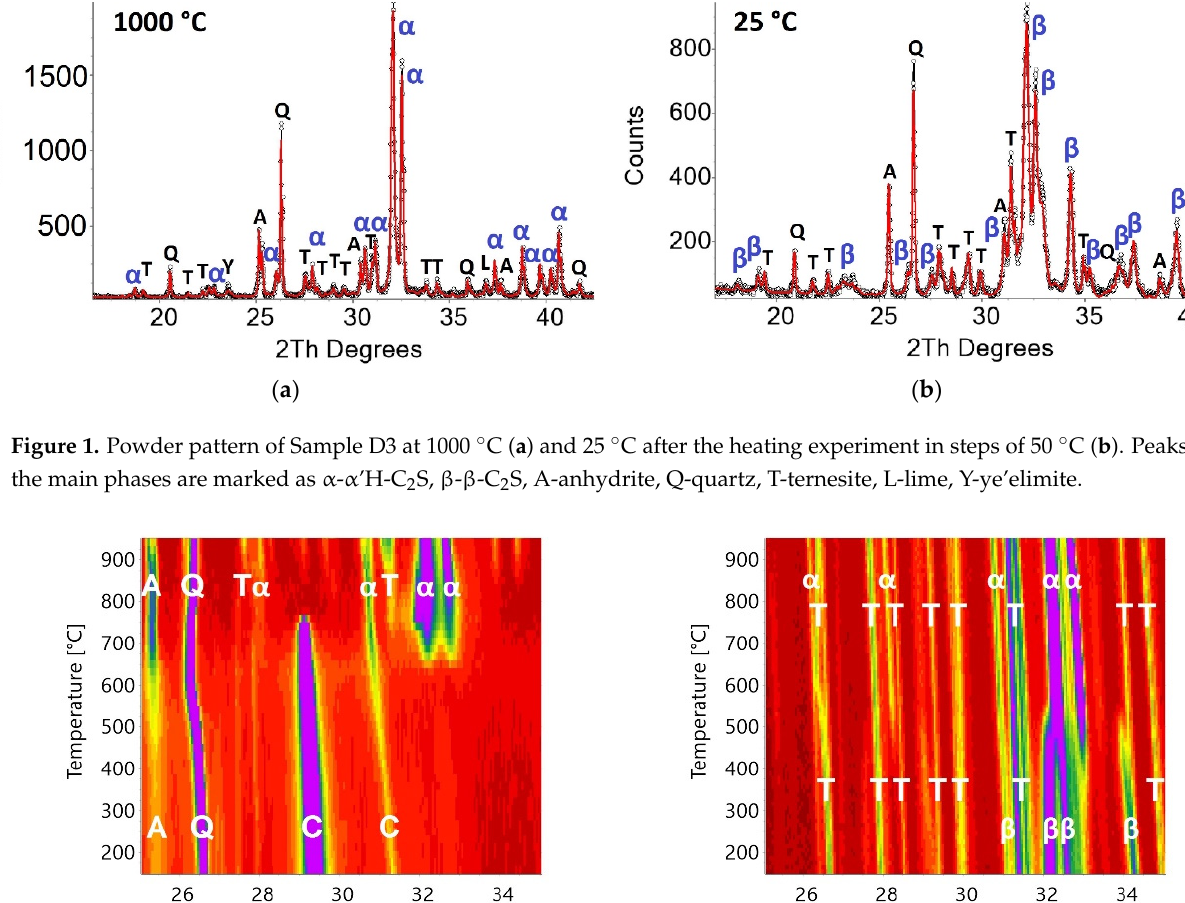
Figure 1. Powder pattern of Sample D3 at 1000 °C ( a ) and 25 °C after the heating experiment in steps of 50 °C ( b ). Peaks of the main phases are marked as α - α ’H-C 2 S, β - β -C 2 S, A-anhydrite, Q-quartz, T-ternesite, L-lime, Y-ye’elimite.